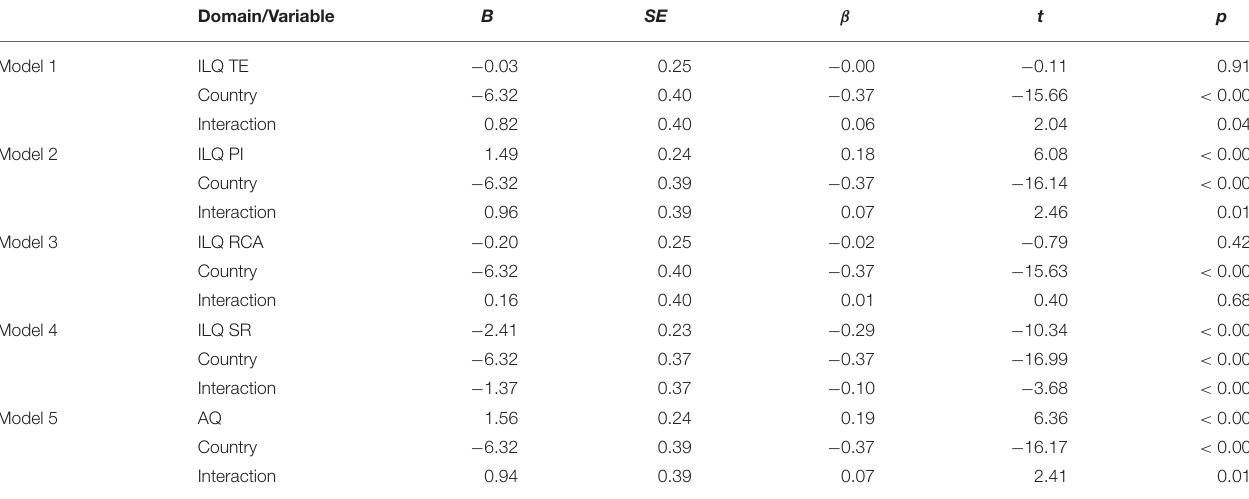
TABLE 6 | Regression coefficients of the moderated regression analyses with s-IAT total scores as dependent variable. Domain/Variable B SE β